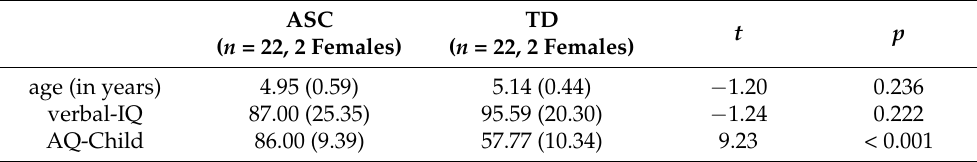
Table 1. Demographics (mean ± SD) of the ASC and TD groups in Experiment 1.